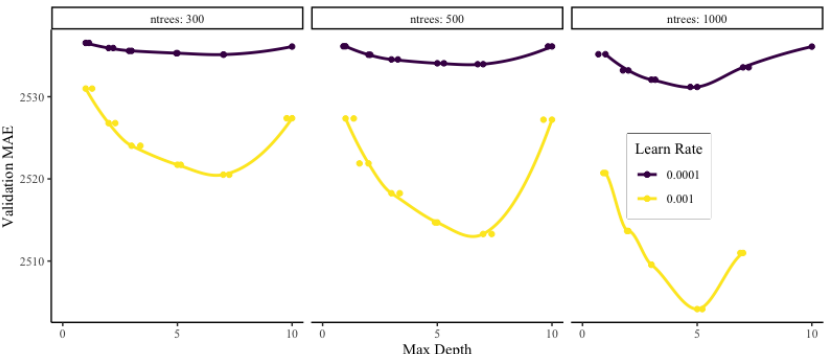
Figure 12. Visualization of the results from tuning gradient boosted forests to predict severity on the PD data (note that only models with the distribution tuning parameter set to “Laplace” are shown since their MAE was much less than the other models). Validation MAE is shown on the y -axis as it changes according to the maximum depth of each tree in the gradient boosted forest. Each pane shows a different number of trees in the forest while each colored line represents a different learning rate.